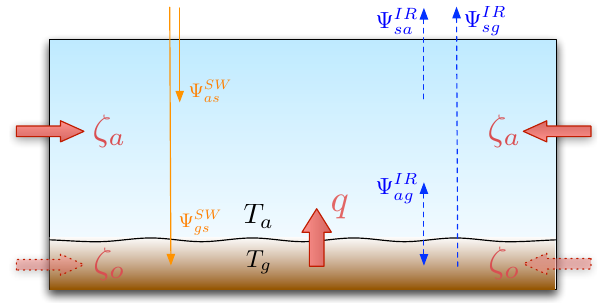
Fig. 1. A grid cell of the model, adapted from Herbert et al. (2010). 9 ν are the energy exchange rates per unit surface due to radiative ij transfer (see text), q is the surface heat flux and ζ a is the atmospheric energy convergence. Over the oceans, there is also an oceanic en- ergy convergence ζ o